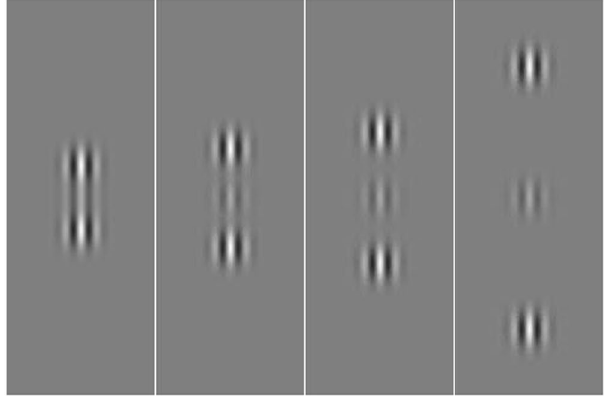
Figure 2. Stimuli used for the lateral masking paradigm. Increasing target-to-flanker separations of 2 λ , 3 λ , 4 λ , and 8 λ are